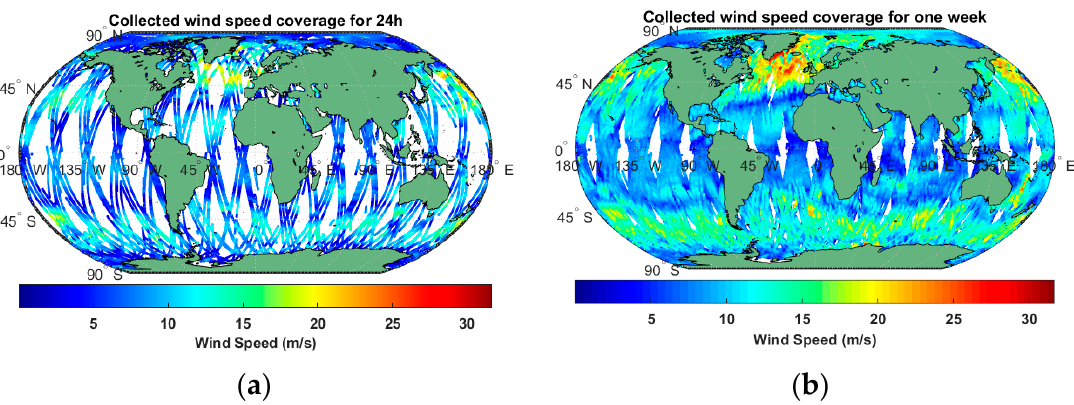
Figure 2. The TRITON reflection observation coverage, respectively, for ( a ) 24 h and ( b ) 7 days represented by wind speed. The color indicates the coincident wind speed obtained by interpolating the European Centre for Medium-Range Weather Forecasts (ECMWF) data.